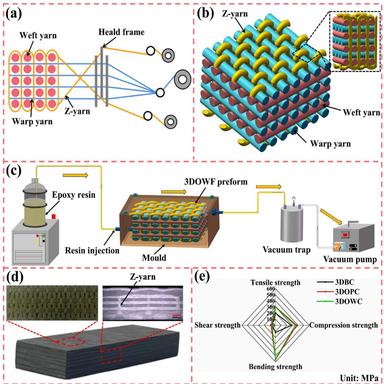
Preparation and mechanical properties of 3DOWC. (a) Schematic diagram of 3DOWF preform weaving and (b) Schematic diagram of 3DOWF structure. (c) Schematic diagram of VARTM curing process. (d) Physical map of 3DOWC. (e) Wind direction rose diagram of mechanical properties of composites with different structures.